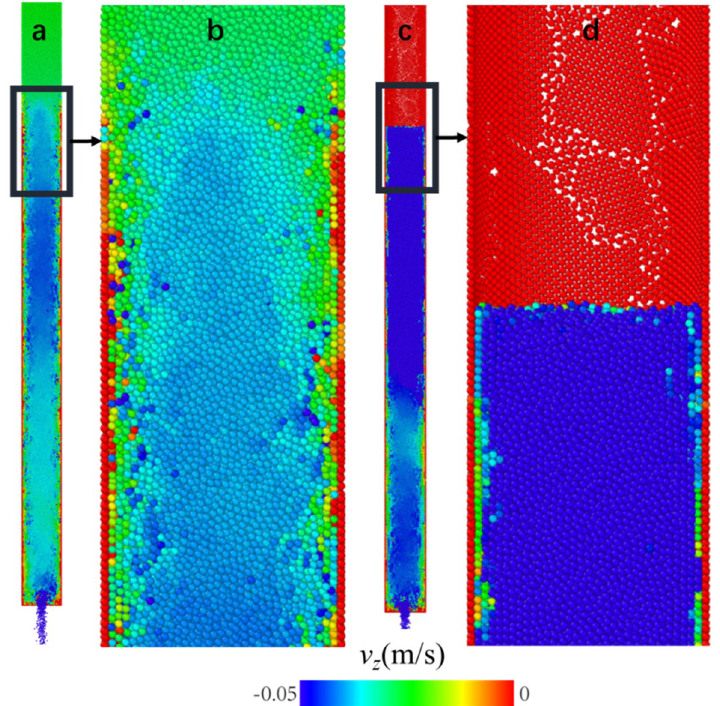
Figure 5. ( a ) A cross section of the flow at a stage when the crystallized shell does not reach the descending top surface. ( b ) Enlarged picture of the part around the growing shell surface in ( a ). ( c ) The cross section of the flow when the top surface level is below the shell surface. ( d ) Enlarged picture of the part around the top surface in (c), with the developed shell reaching well above the surface. The results in this figure is visualized by 45